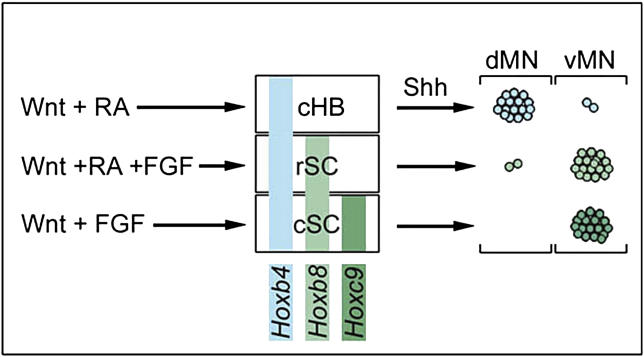
Combinatorial Wnt, RA, and FGF Signals Specify Progenitor Cell Identity That Prefigure MN Subtype in the Developing Hindbrain and Spinal CordCombinatorial actions of Wnt, FGF, and RA signals specify neural progenitor cells expressing
Hox gene profiles characteristic of the cHB, rSC, and cSC that generate patterns of differentiated MNs, with dMN or vMN exit points, characteristic of hindbrain and spinal cord, in response to Shh signaling.